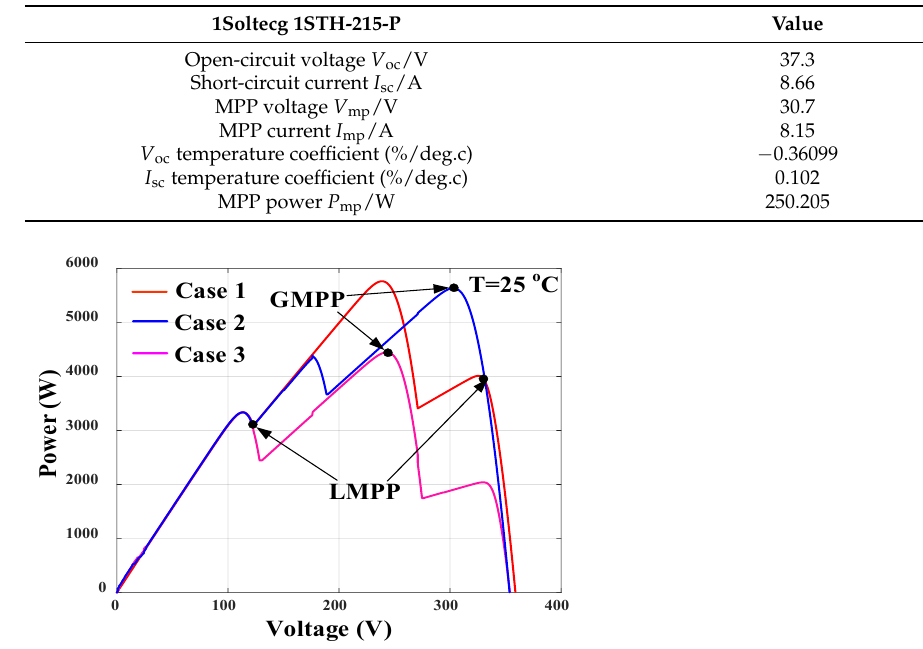
Table 1. Electrical parameters of PV array.